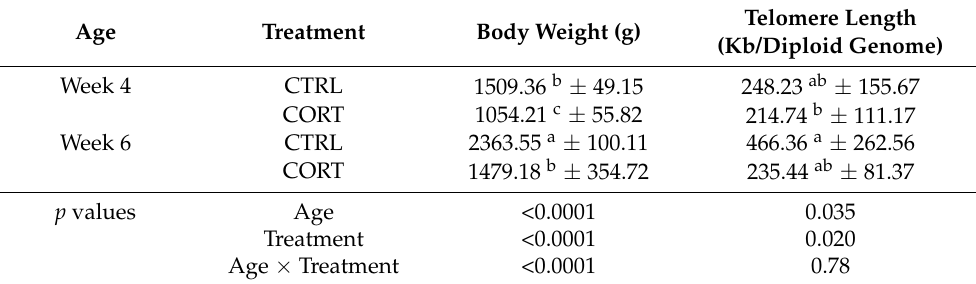
Table 3. Effect of corticosterone administration and age on body weight and buffy coat telomere length ( ± SD) of broiler chickens.